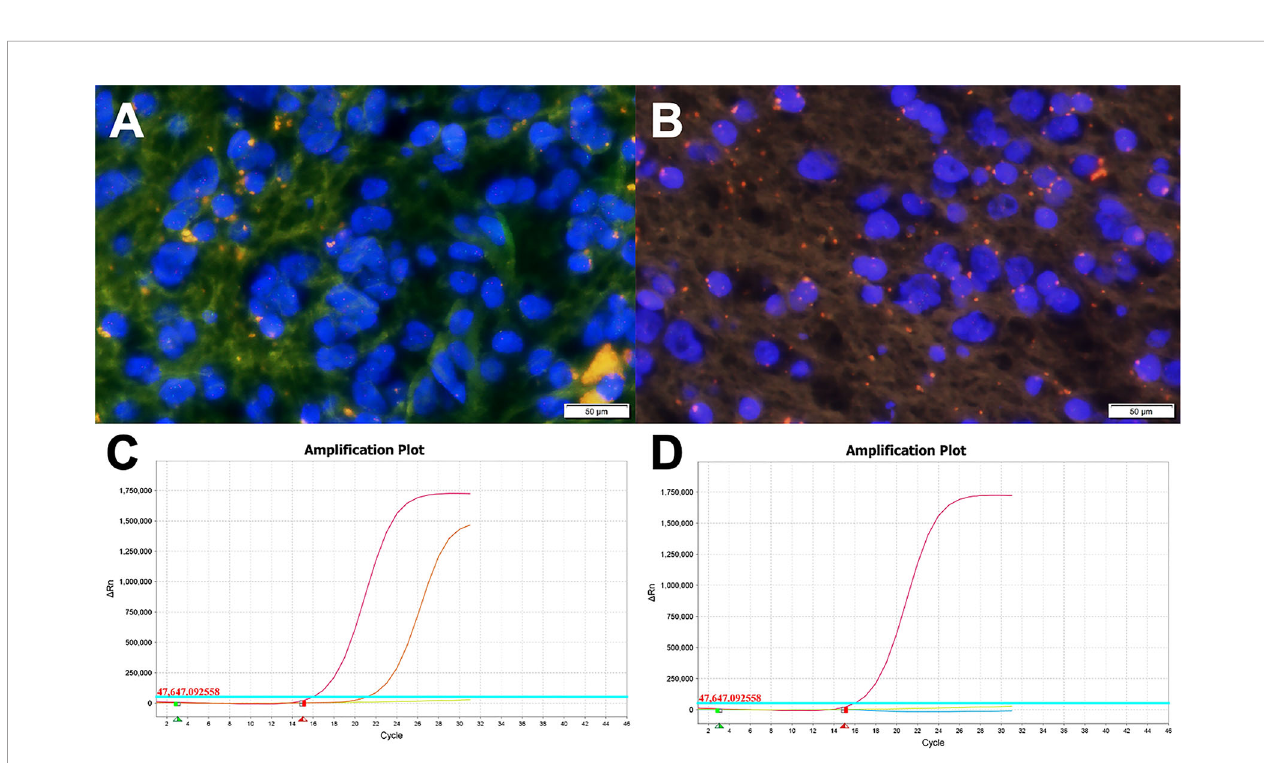
FIGURE 4 | Molecular examination images of PLNTY. (A, B) FISH analysis for 1p/19q showing absence of chromosome 1p/19q deletion (Case c). (C) The BRAF V600E gene mutation was detected by the Real-Time PCR technique. The orange curve, the red curve, the green line, and the blue line represented the tested sample, the positive control, the negative control, and the threshold line respectively. The FAM signal, as seen in Case c, had an obvious ampli fi cation curve, and the CT value is less than 28, which means the BRAF V600E mutation is positive. (D) The BRAF V600E gene mutation of Case a (the blue line representing the tested sample). The test result was negative for the BRAF V600E gene mutation as the FAM signal had no ampli fi cation